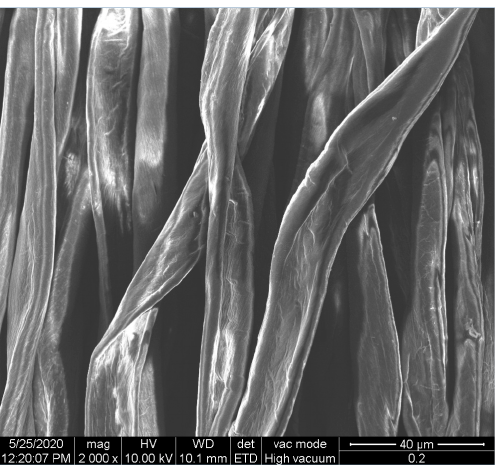
Figure 6. The sample was treated using RF 2 plasma O 2 using kHz generator and power 100 W. ( a ) represents the image of the sample treated using RF plasma O 2 kHz and power 100 W, respective ( b ) represents the sample treated with Ni-based paste.